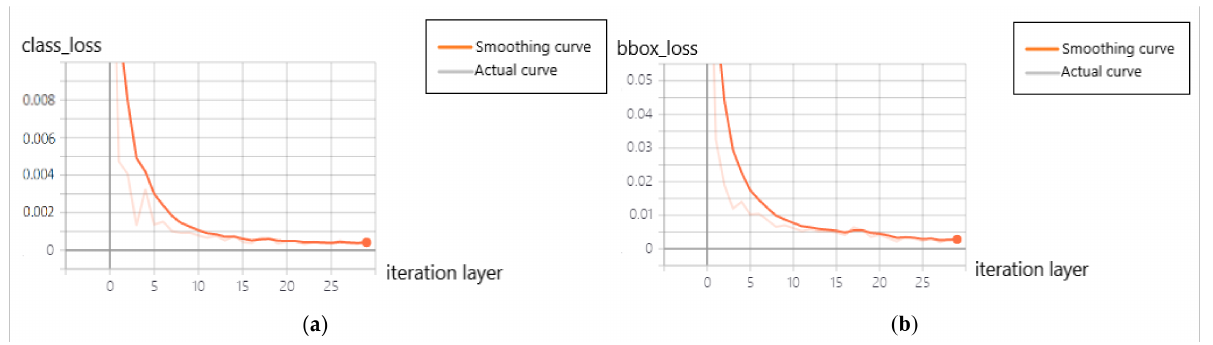
Figure 20. Mask R-CNN loss function 3. ( a ) Class loss, ( b ) bbox loss.